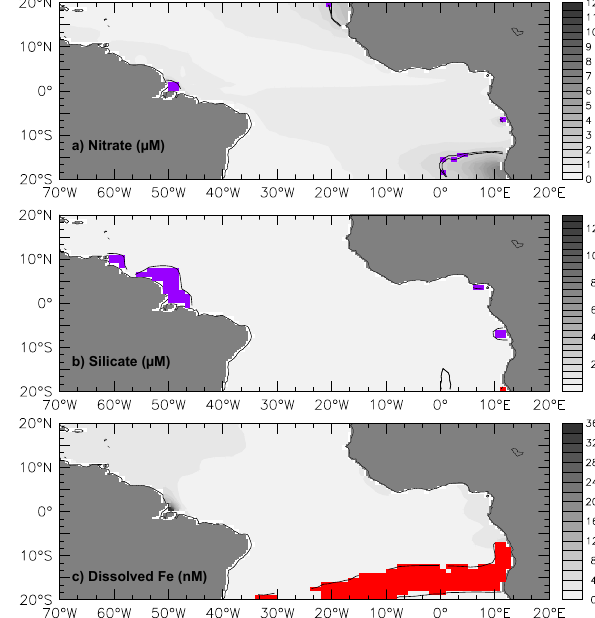
Fig. 8. Surface mean fields (average 1998–2005) from the TODAY standard scenario for (a) NO 3 inµM, (b) Si inµM, and (c) Fe in nM. Red areas correspond to regions where surface nutrient concentra- tion in the TODAY scenario drops below the threshold contour of diatoms K m (half saturation growth constant) when compared to the NO_RIVER scenario. Purple areas show the reverse. Thresh- olds are set to (a) 2.0µMNO 3 , (b) 0.42µMSi, and (c) 0.17 nM Fe. Red areas give a rough indication where diatom nutrient limitation has become more severe. Purple areas correspond to regions where diatom nutrient limitation has been